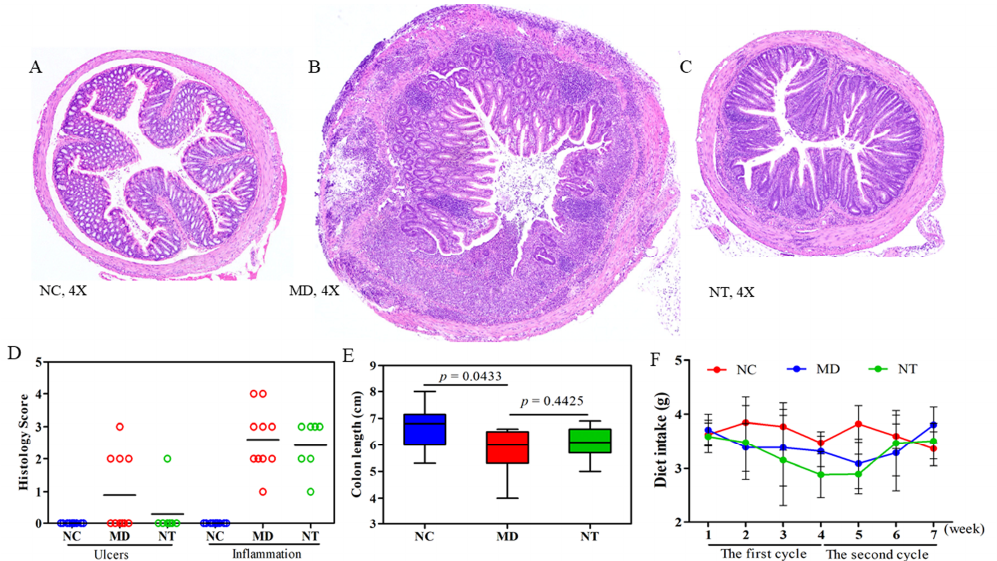
Figure 1. Neoagarotetraose (NT) promoted mucosal healing in dextran sulfate sodium (DSS)-induced murine colitis mice. Hematoxylin and Eosin staining of A : normal controls (NC), B : colitis induced by DSS (MD), and C : colitis mice supplemented with NT. D : Historical scores of ulceration and the number of inflammatory infiltrates was improved due to NT supplementation. E : The colon length was significantly reduced by DSS. F : Daily feed intake during the two DSS cycles.